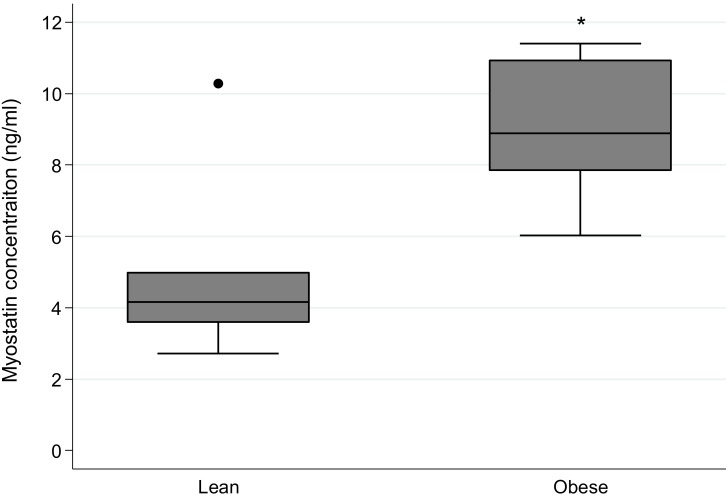
Circulating concentrations of myostatin protein in lean and obese horses and ponies.Circulating concentrations of mature myostatin protein were measured in blood serum using a commercially available ELISA kit. *denotes where values differ significantly (p<0.05) from lean group. n = 6/group.